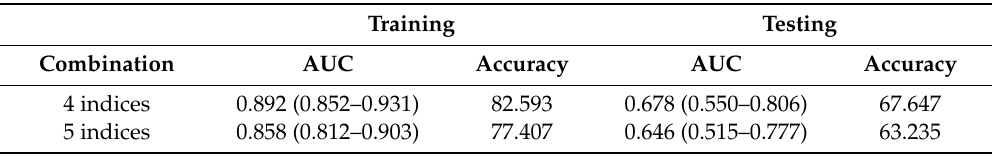
Table 5. Results of the training and testing of the support vector machine. The area under the ROC curve and the accuracy are presented with their 95% confidence